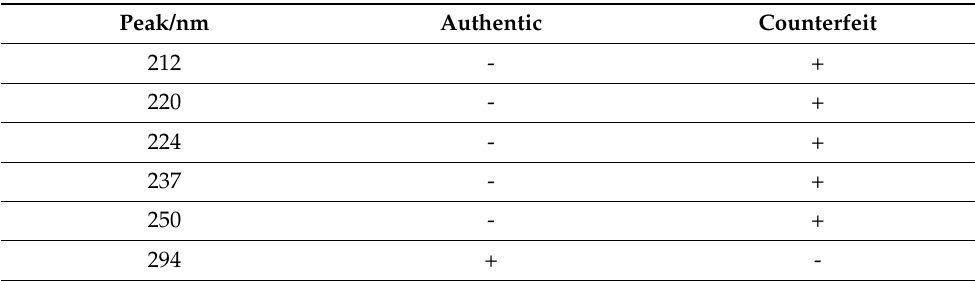
Table 6. List of main peaks which are missing in the authentic 100 NIS banknote and present in the counterfeit (and vice